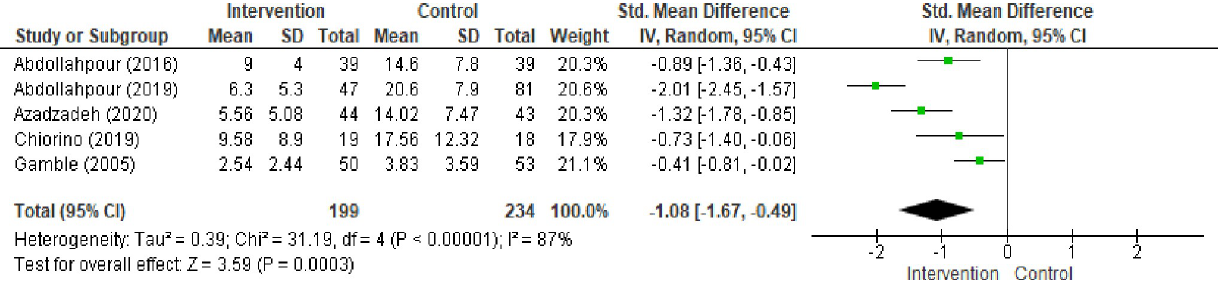
Fig 5. Forest plot: Symptom severity 12 weeks